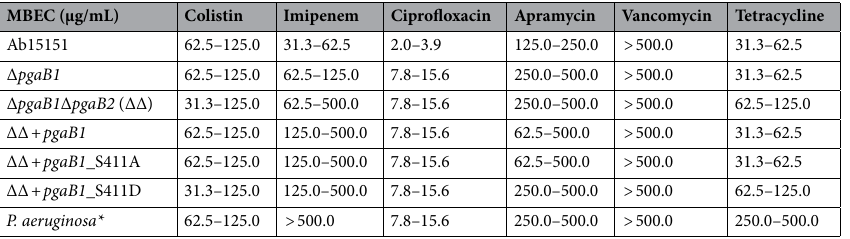
Table 3. Minimum biofilm eradication concentration to Ab15151 and its derivative mutant strains. *MBEC to P. aeruginosa ATCC 27853 was performed as standard control.